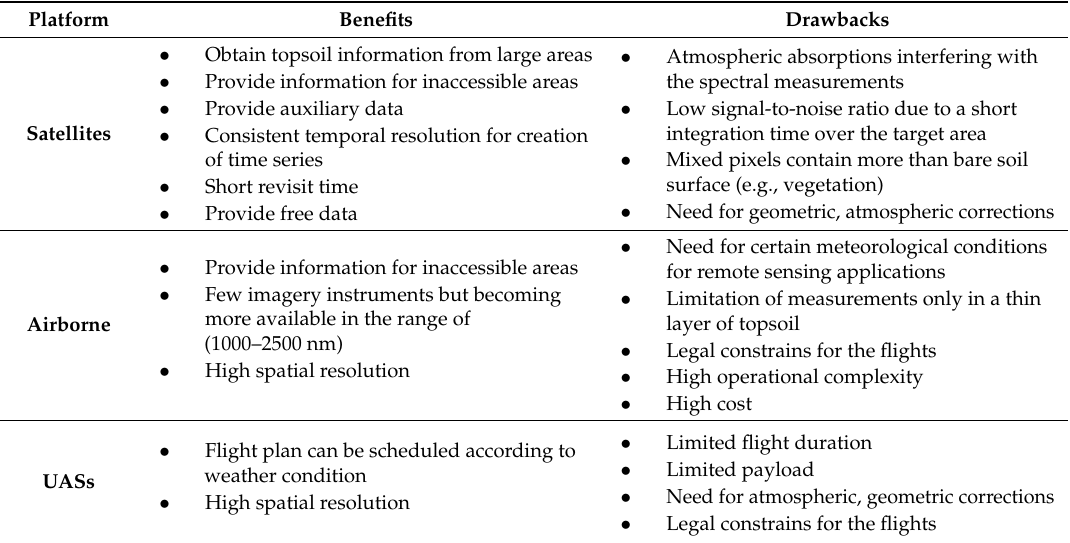
Table 4. Summary of RS platforms for SOC monitoring in terms of their benefits and drawbacks.